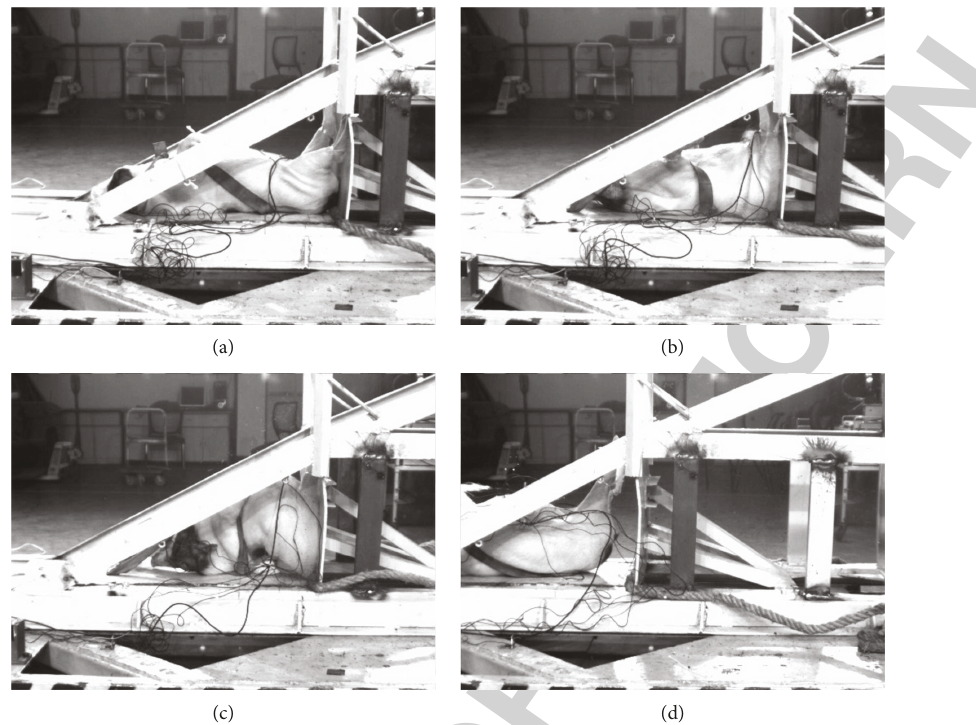
Figure 3: The kinematics of the pig during the CCI. (a) T0: the sled is hitting against the wall but the pig was motionless to the carriage. (b) T1: the pig showed maximal deformation of the abdomen due to severe compression of the torso along the caudocephalad direction. (c) T2: peak point of the spine bending. The maximal height (MH) indicated with the arrows refers to the distance between the peak point of the spine bending and the deck of carriage. (d) T3: the spine returned to normal form.